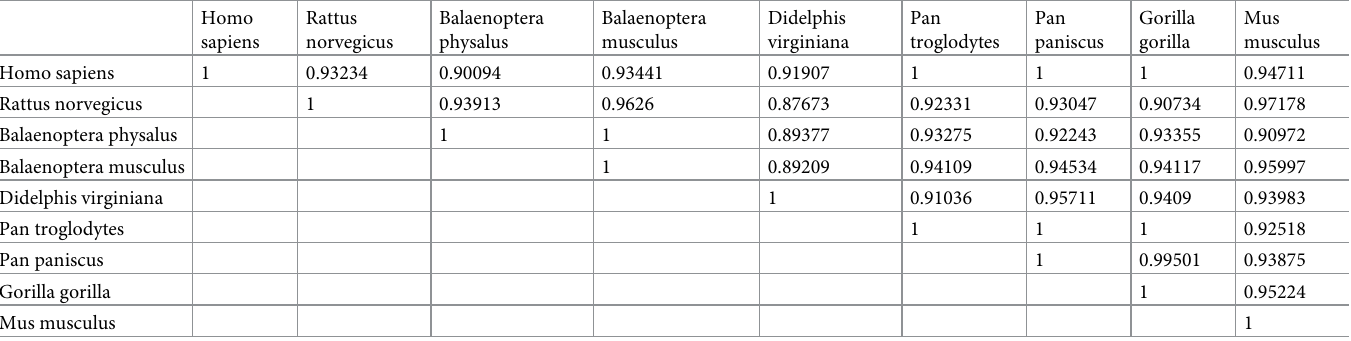
Table 13. The parameter Matthew’s Coefficient Correlation (MCC) of the HELIOS method with referencing the Smith-Waterman algorithm in the accuracy mea- surement of classification output. The assumed dataset is the “Nine ND5 protein sequences dataset” [53] in this